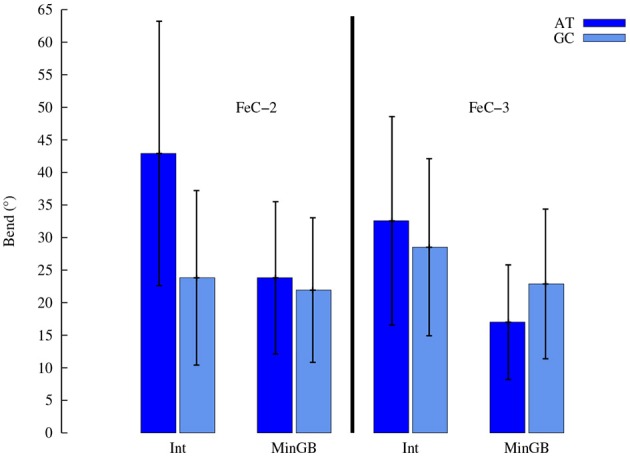
Average global helix bending induced by FeC-2 and FeC-3. Error bars represent the standard deviation, the relative high value being due to the relative short length of the double strands.